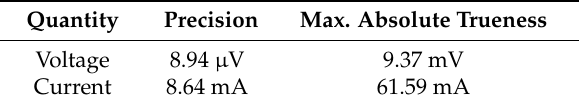
Figure 12. ( a ) pdf of a set of values measured on the current input channel of the CST when shorted; ( b ) absolute error linear fit over 14 values to determine the CST “trueness” on the entire input range. Table 3. CST voltage and current measurement accuracy.